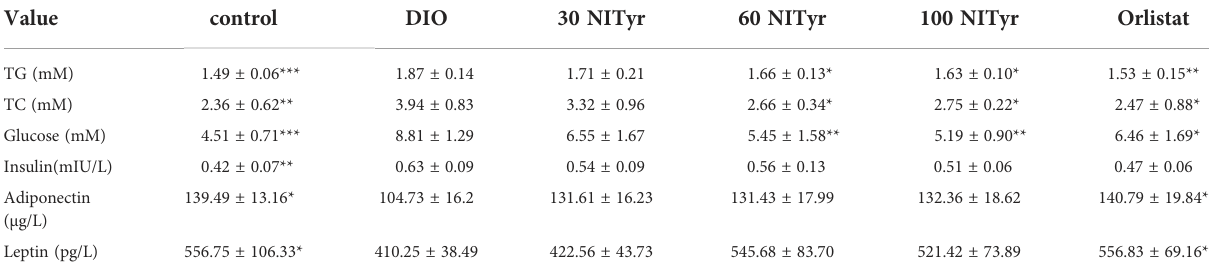
TABLE 4 Analysis of glucose and metabolism indexes in serum in mice after 4-week administration of